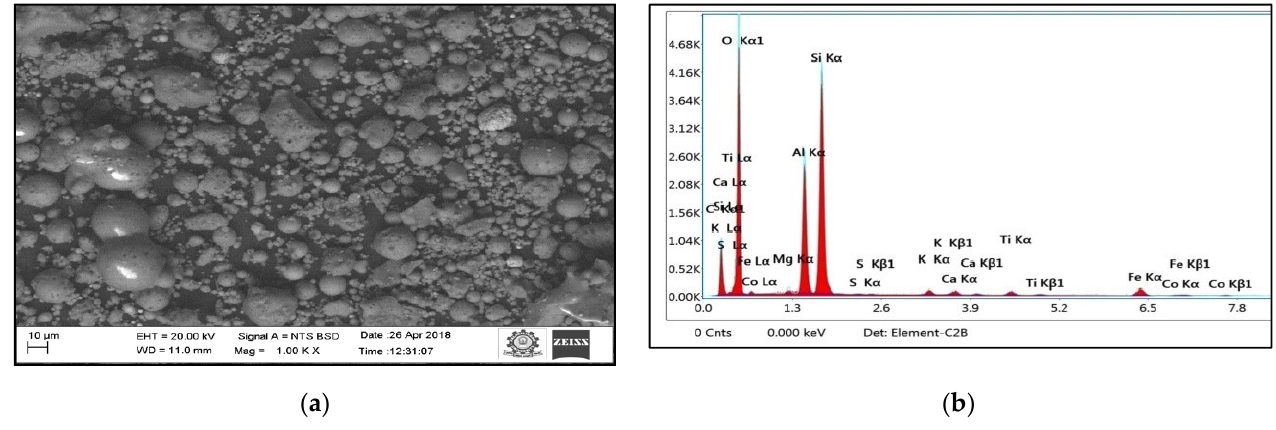
Figure 2. ( a ) SEM image of Class C fly ash; ( b ) EDAX image of Class C fly ash.